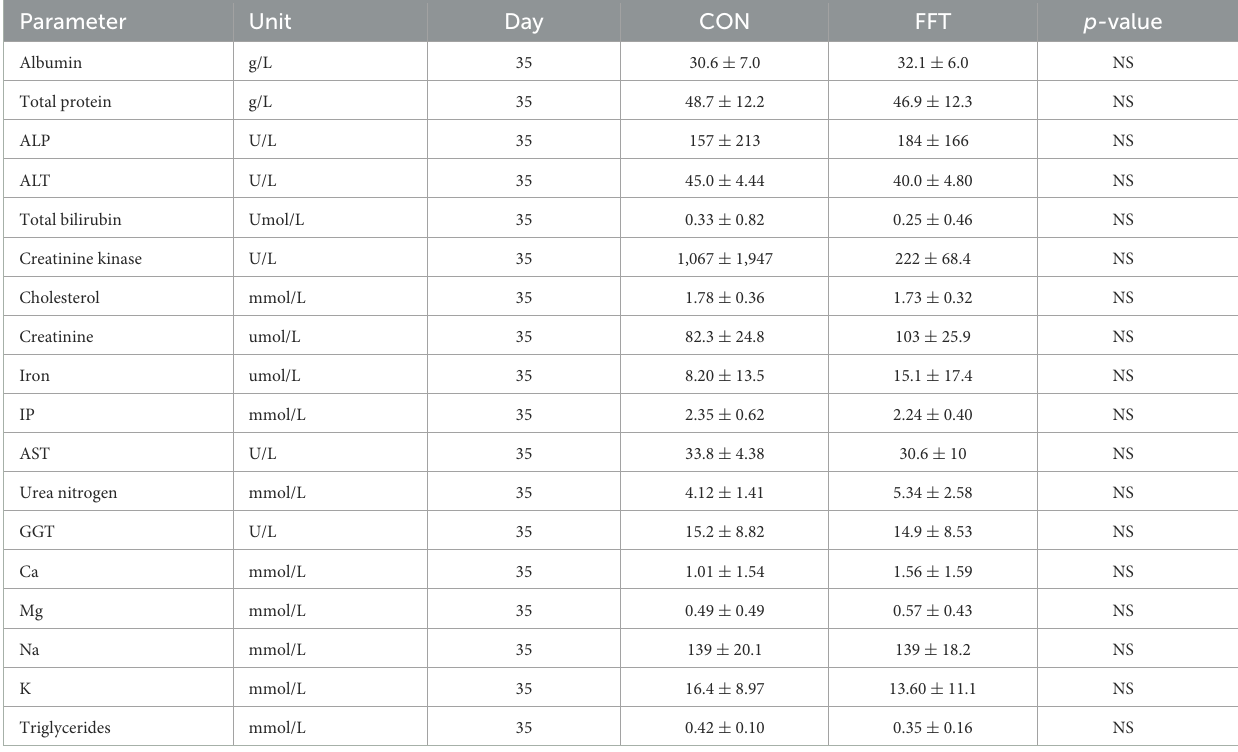
TABLE 9 Biochemistry parameters of piglets on day 35 ( n = CON: 6; FFT: 8). Parameter